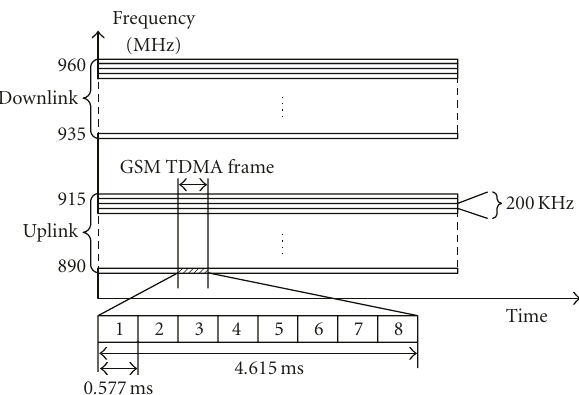
Figure 9: The GSM system includes the downlink/uplink bands. Each GSM frame consists of 8 time slots